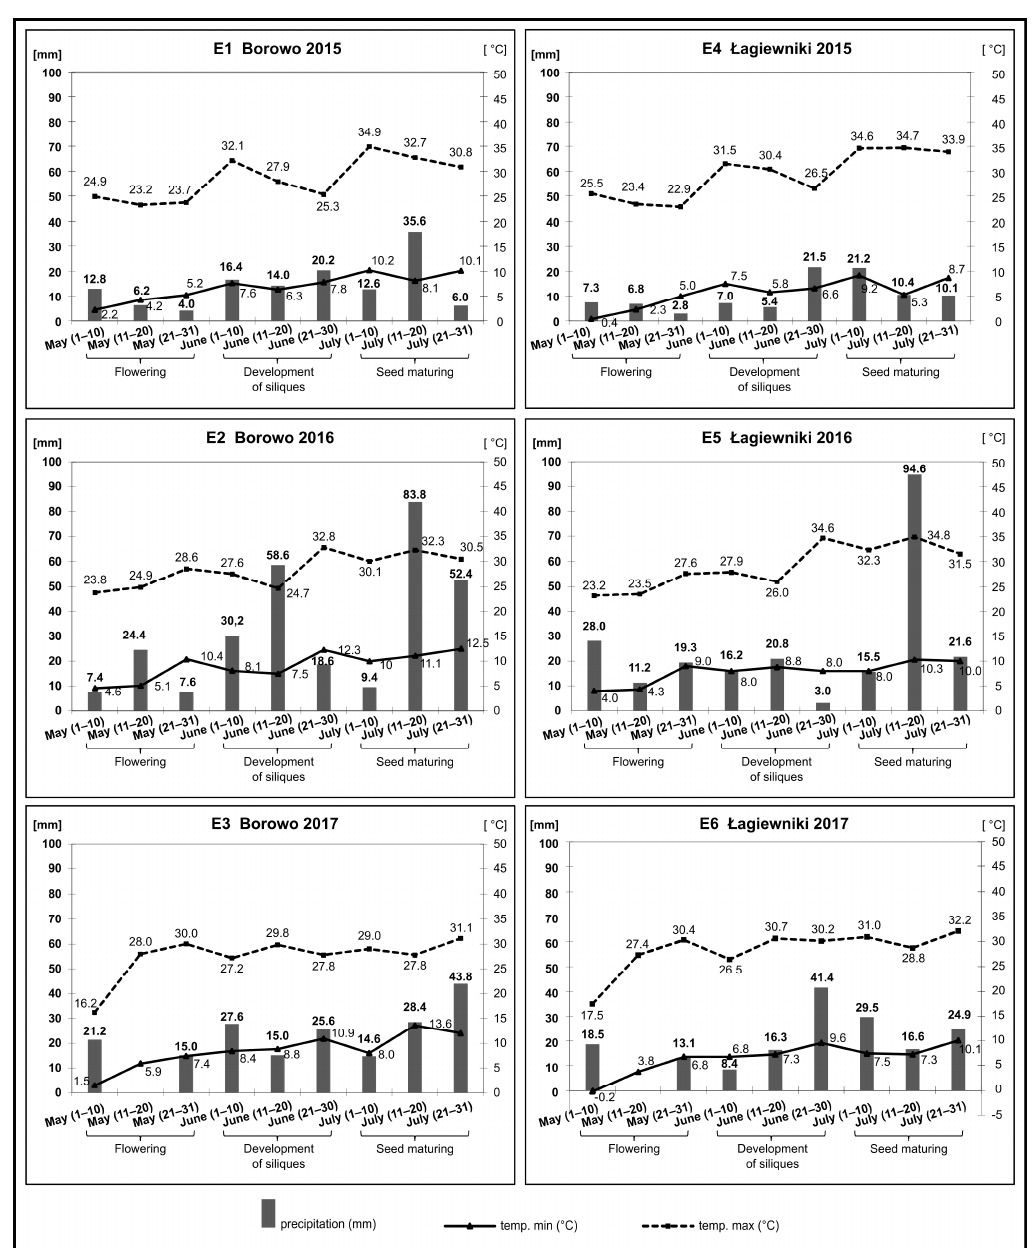
Figure 1. Weather conditions during flowering, development of siliques and seed maturing in 6 environments (E1–E6); dark grey bars, precipitation [mm]; black solid and dashed lines, minimum and maximum temperatures [ ◦ C],